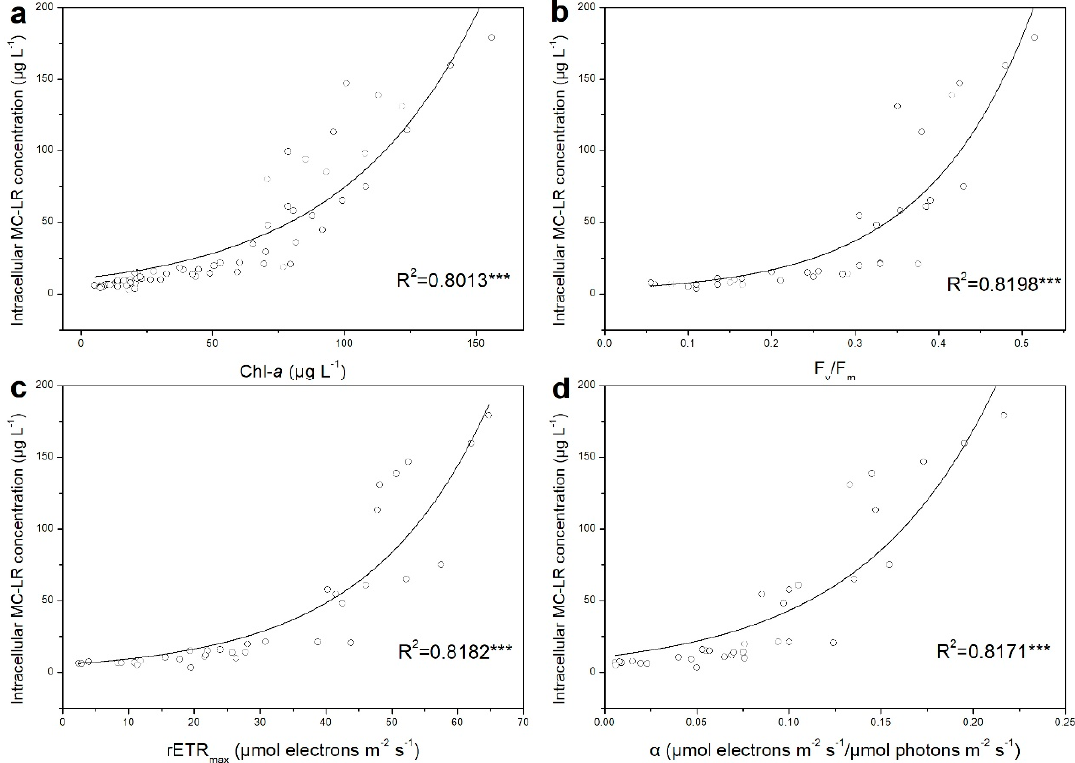
Figure 4. Relationship between physiological activity and intracellular MC–LR concentration of M. aeruginosa FACHB–905 (( a ): Chl- a (chlorophyll- a ) content, n = 70; ( b ): F v /F m , maximal quantum yield, n = 35; ( c ): rETR max , maximal relative electron transport rate, n = 35; ( d ): α , photosynthetic efficiency, n = 35). Both the R 2 and significance level are indicated; *** p < 0.001.